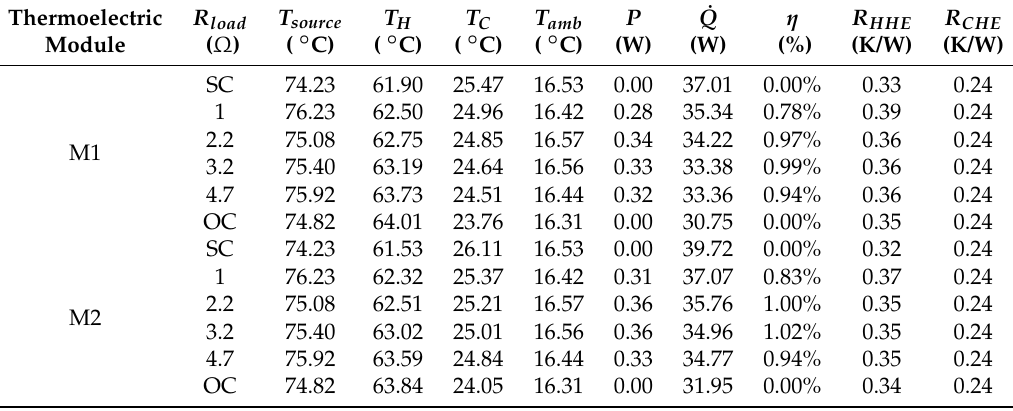
Table 1. For each thermoelectric module (M1 and M2) and load electrical resistance R load , temperatures of the heat source T source , the hot and cold side of the thermoelectric modules T H and T C , and ambient T amb , power generated P , heat flux extracted from the source ˙ Q , efficiency of the thermoelectric modules η , and thermal resistances of the hot and cold side heat exchangers (HHE and CHE